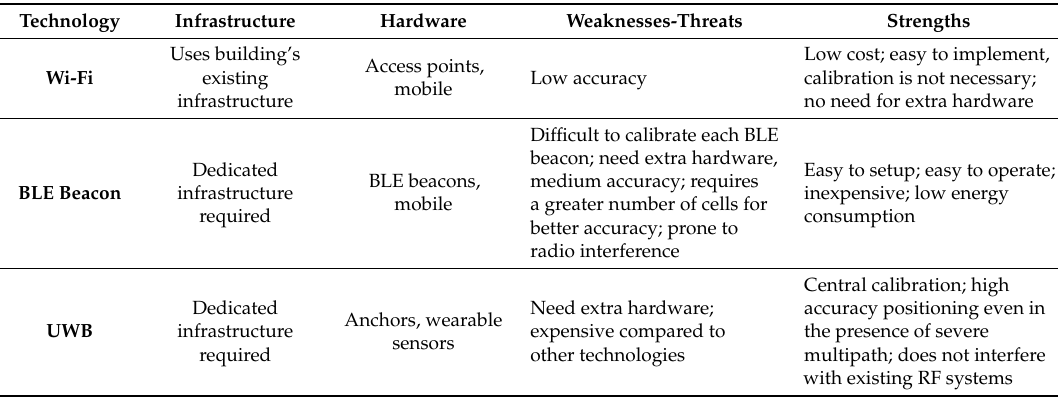
Table 2. Comparison of selected indoor positioning